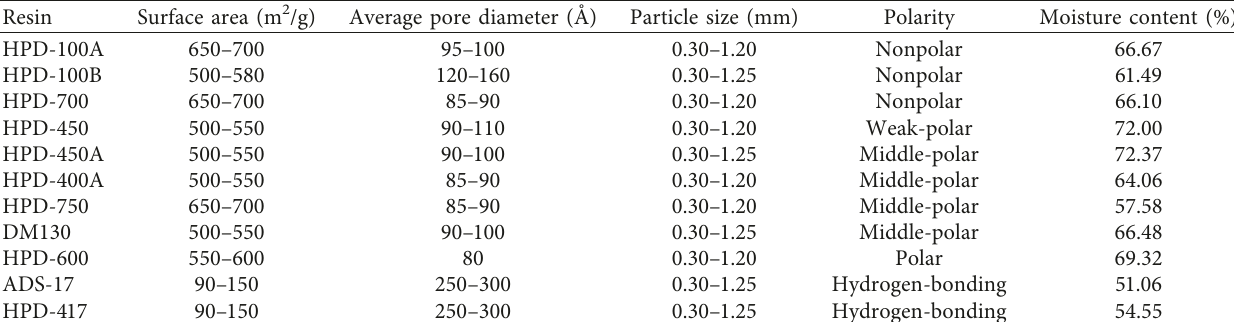
Table 1: Physical properties of the tested